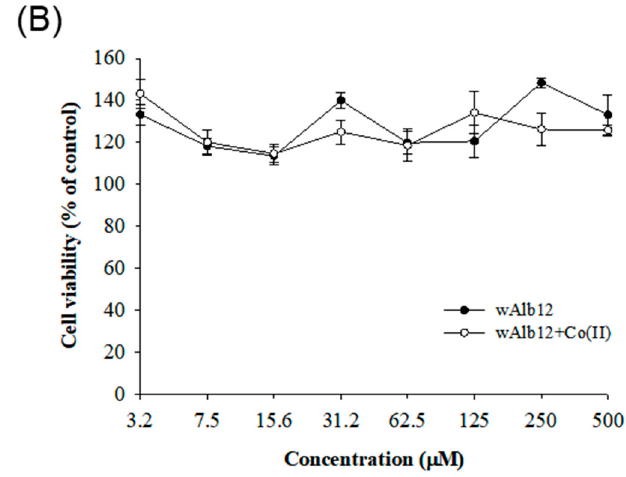
Figure 8. The cell viability of the wAlb12 and wAlb12 + Co(II) complex. Cell viability in RAW 264.7 cell ( A ) and in HEK 293t cell ( B ).